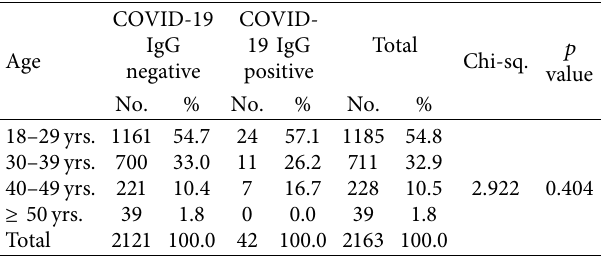
Table 3: COVID-19 IgG positive status among blood donors according to age.